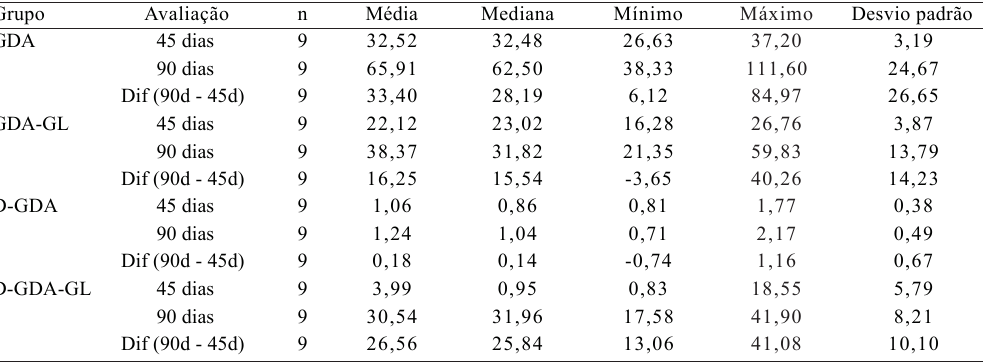
Tabela 2. Valores de cálcio por grupos nos diferentes intervalos de